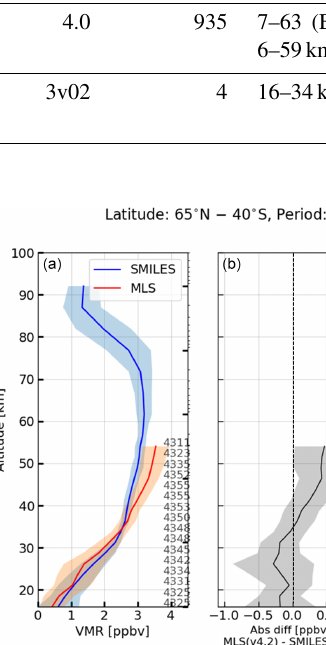
Figure 5. Comparison between SMILES and MLS profiles from 24 to 27 January 2010. (a) Mean HCl VMR values (solid lines) and 1 σ (shaded areas) for SMILES and MLS. The blue and red lines indicate the SMILES HCl profiles and MLS profiles, respectively. (b) The absolute difference between the SMILES and MLS pro- files calculated using Eq (3). (c) The relative difference between the SMILES and MLS profiles calculated using Eq